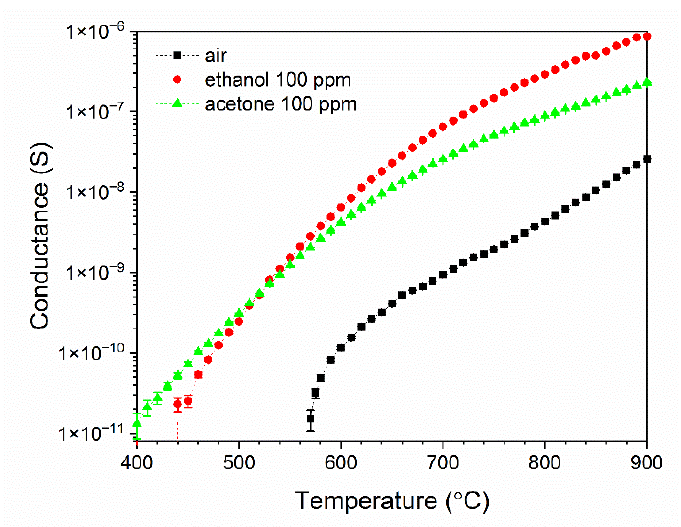
Figure 15. Change of conductance of β -Ga 2 O 3 nanowires as a function of temperature in ambient air, and ethanol or acetone with the concentration of 100 ppm.